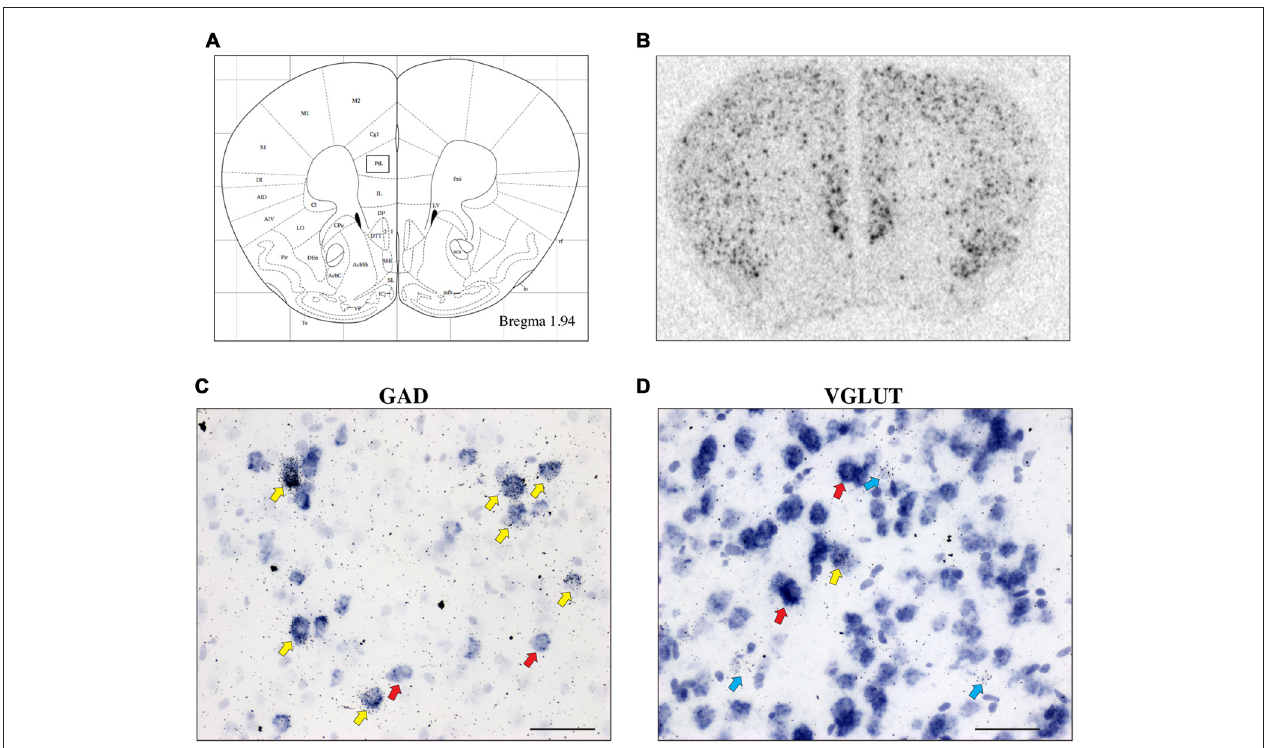
FIGURE 1 | The expression of corticotropin-releasing hormone-binding protein (CRH-BP) mRNA in excitatory (vesicular glutamate transporter (VGLUT)-expressing) and inhibitory (glutamic acid decarboxylase (GAD)-expressing) neurons in the prefrontal cortex (PFC). Coronal section from the Paxinos and Franklin (2001) mouse brain atlas (A) at Bregma coordinate 1.94 mm, highlighting the prelimbic region of the PFC where the images in (C,D) were captured. An in situ autoradiogram (B) shows abundant CRH-BP mRNA expression throughout the PFC. Higher magnification bright field images show a high degree of colocalization between CRH-BP and GAD (GAD65 and GAD67) mRNA (C) and a low degree of colocalization between CRH-BP and VGLUT (VGLUT1 and VGLUT2) mRNA (D) in the prelimbic PFC. Cells labeled for CRH-BP only (silver grains) are indicated with blue arrows, examples of cells labeled for GAD or VGLUT only (purple digoxigenin signal) are indicated with red arrows, and dual-labeled cells are indicated with yellow arrows. Images shown are from prelimbic cortical layers III and V (C) and II and III (D) . Midline is on the right side of panels (C,D) . Scale bar: 50 µ